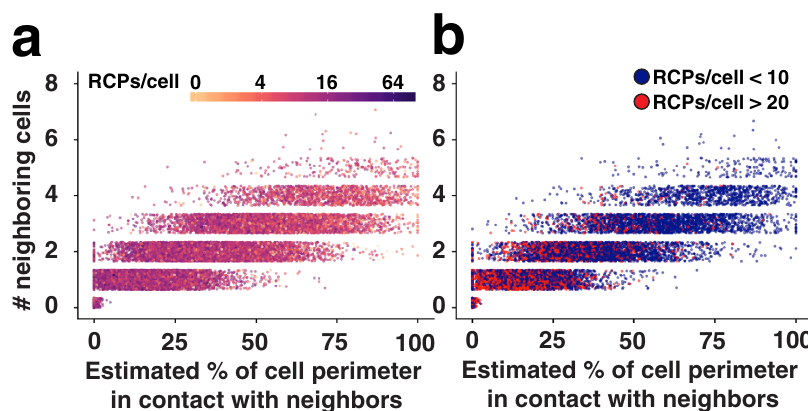
Fig. 4 Smad2 pT220 linker phosphorylation levels in relation to cell crowding/density after 1 h of TGF- β stimulation. Graphs display the estimated percentage of the circumference of each cell that is in contact with other cells (calculated based on nuclear positions of cells and the average size of HaCAT cells) along the X axis and estimated numbers of neighboring cells as inferred via the numbers of nuclei present within a de fi ned distance (20 pixels (~6.6 µ m)) along the Y axis. Graph a displays all cells while graph b , for ease of view and clarity, only displays cells with RCPs >20 as red symbols and RCPs <10 as dark blue